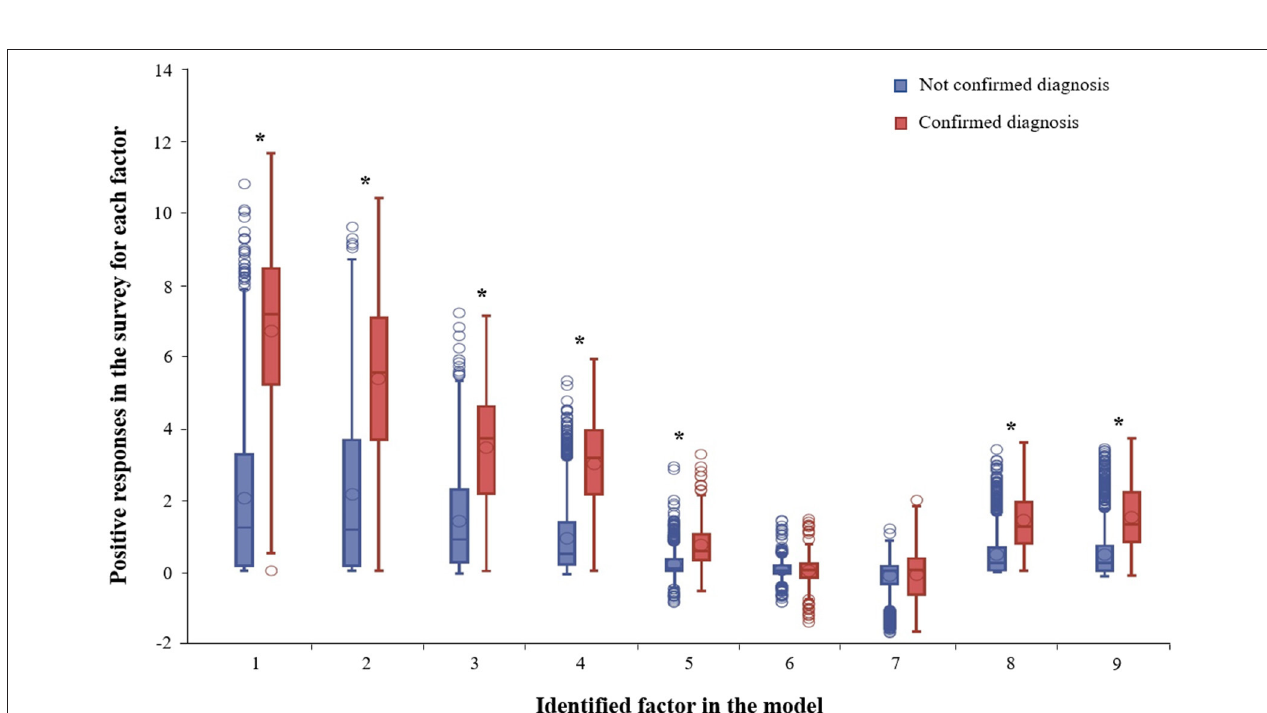
FIGURE 1 | Box plot with positive responses in the survey for each factor identified in the principal component analysis considering the diagnostic confirmation. Asterisks represent statistical differences (Wilcoxon test) found between groups ( p < 0.001).